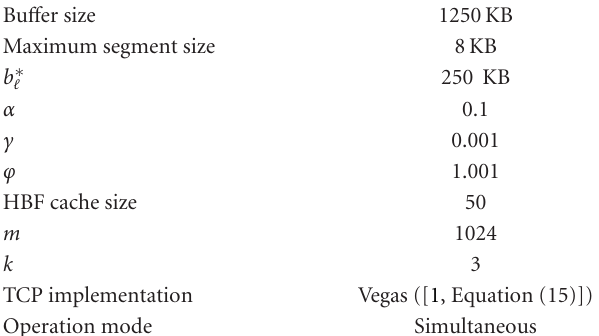
Table 1: Simulation parameters.